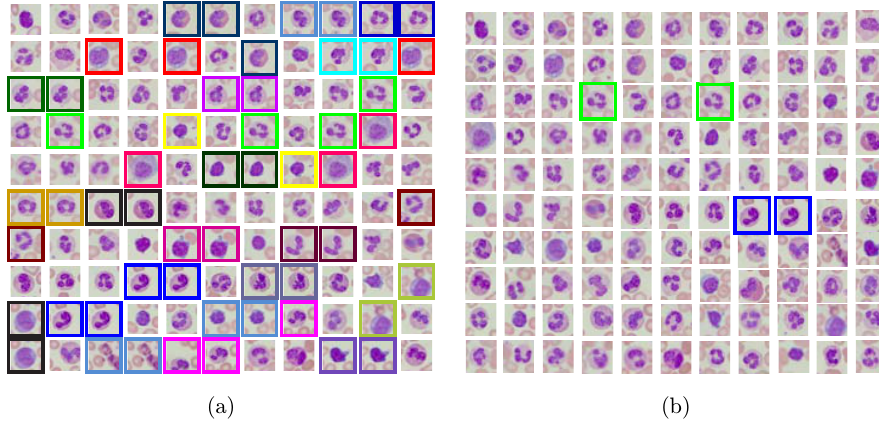
Fig. 6. Results of di®erent methods. (a) Result of no clustering (b) Result of using max – min